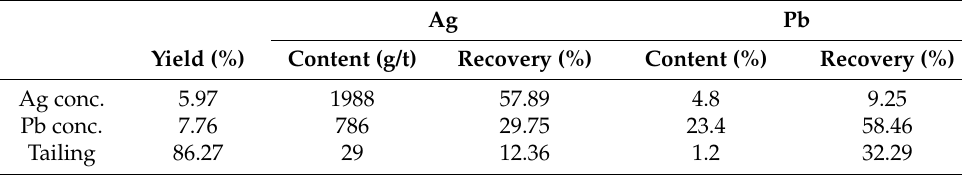
Table 6. Results of the industrial closed-circuit test. Ag Pb Yield (%) Content (g/t) Recovery (%) Content (%) Recovery (%) Ag conc. 5.97 Pb